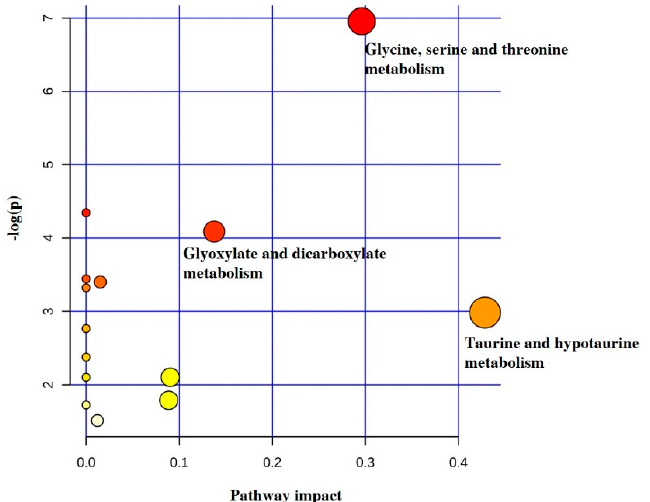
Figure 2. Topology map, generated using MetaboAnalyst, describing the impact of the seven discriminant metabolites identified through comparative analysis of BAV against controls by OPLS- DA. Bubble size is proportional to the impact of each pathway, while bubble color denotes the degrees of significance from highest (red) to lowest (white).